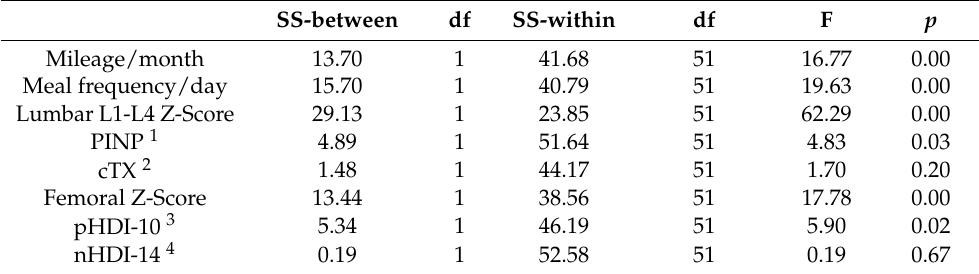
Table 1. The analysis of variance statistics of the K-means clustering of the study group of marathoners. SS-between df SS-within df Mileage/month Meal